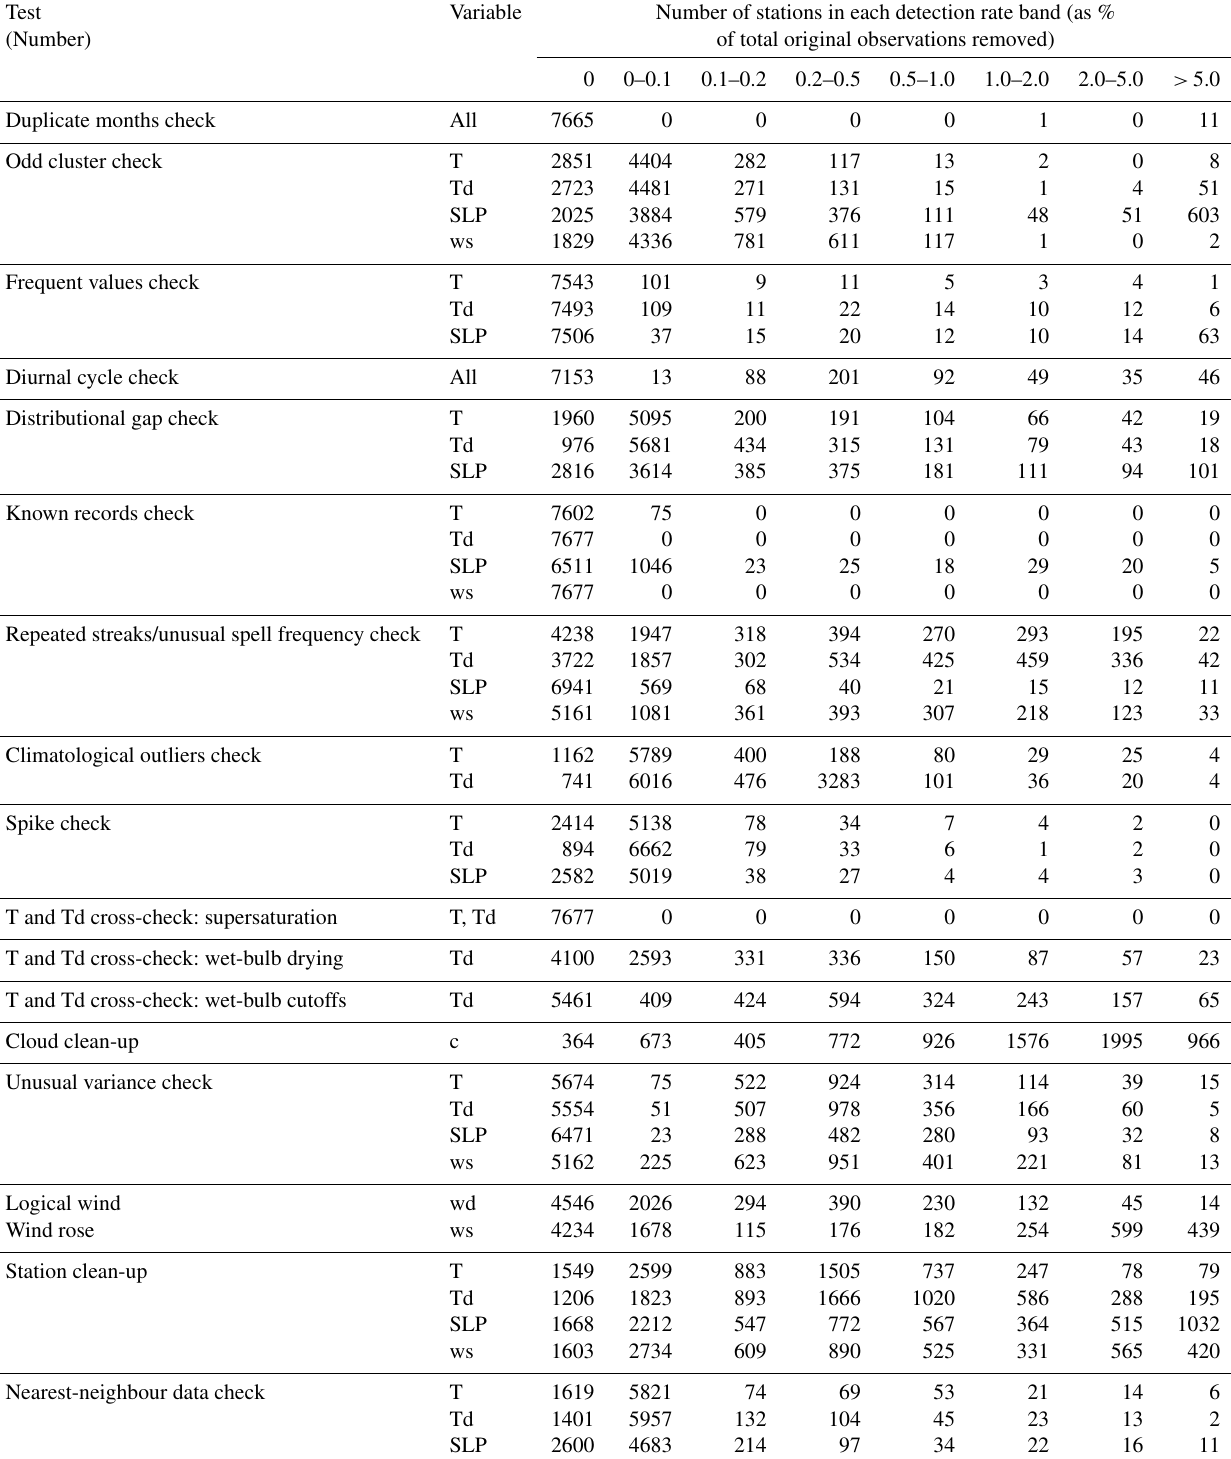
Table 3. Summary of removal of data from individual stations by the different tests for the 7677 stations considered in detailed analysis.